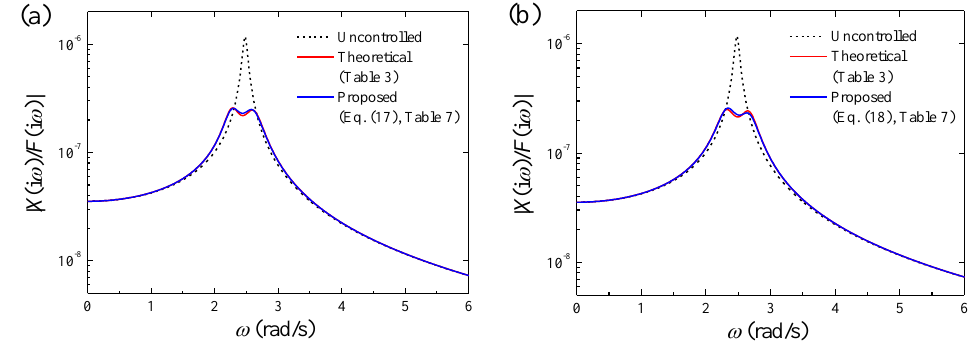
Figure 5. The modulus of frequency response functions | X (i ω )/ F (i ω )| of uncontrolled and controlled